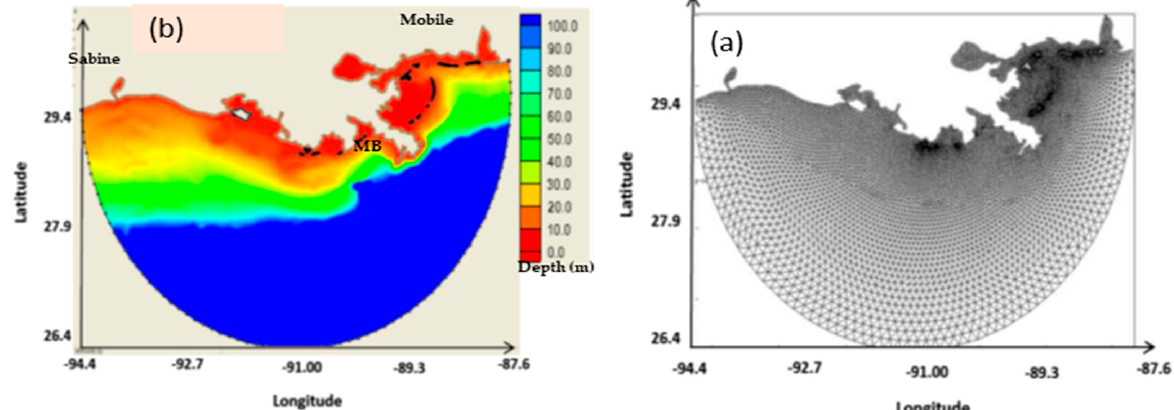
Figure 2. ( a ) Modeling area and bathymetry, ( b ) computational mesh. MB in panel ( a ) stands for Mississippi Bight.